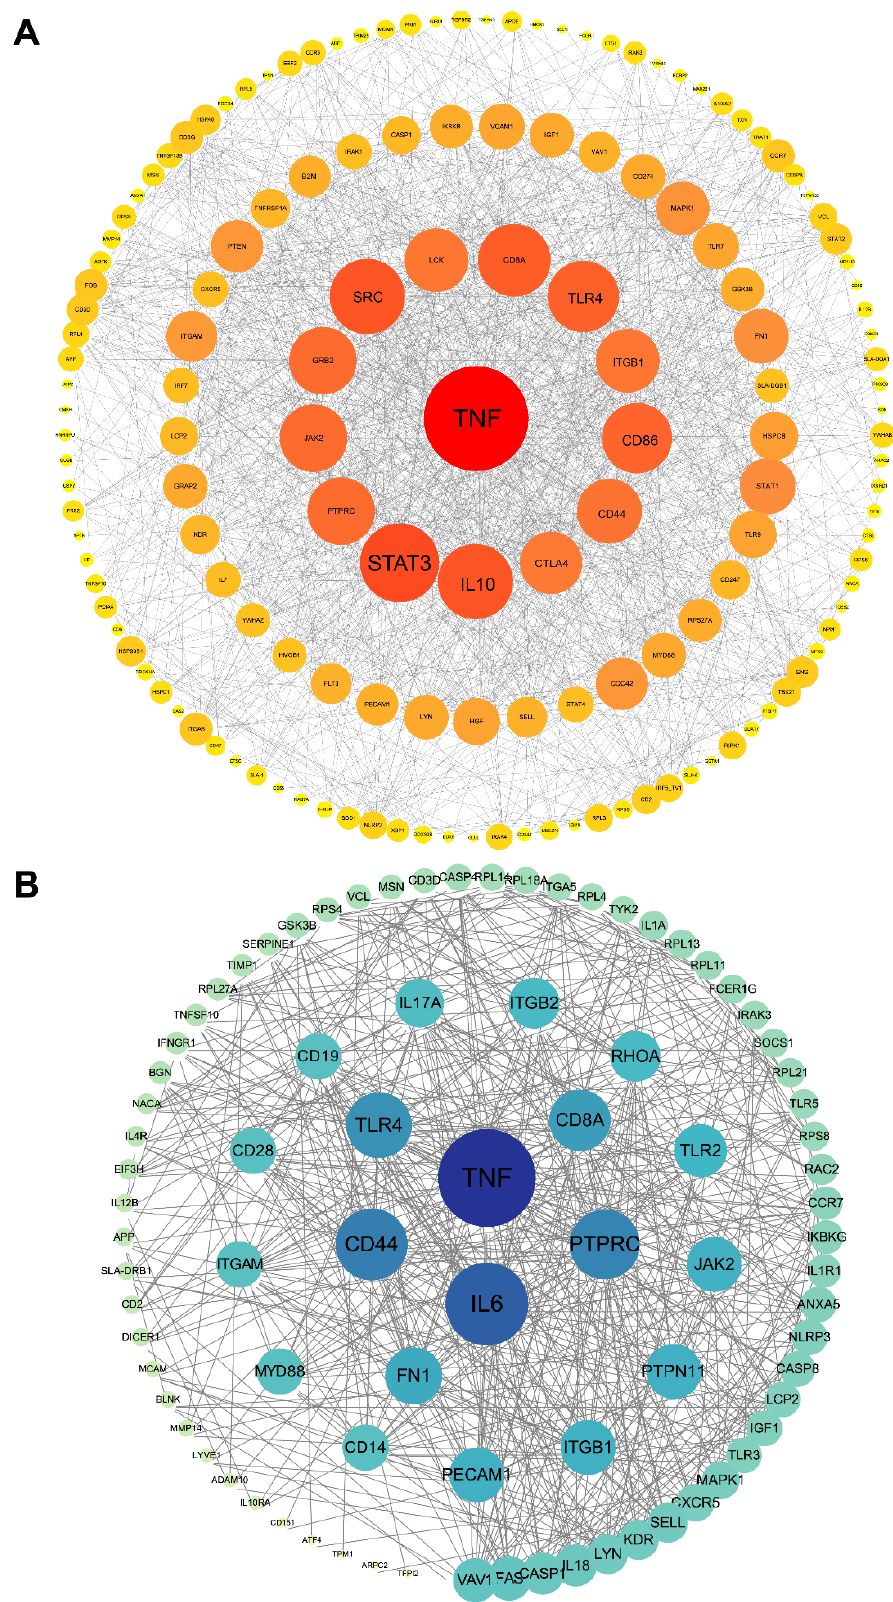
Figure 8. Protein–protein interaction network of target genes. ( A ) shows the interaction network of DEM target genes. ( B ) shows the interaction network of DET target genes. Each circle node represents a gene. The circle size and color scales represent the node degree of the target genes.